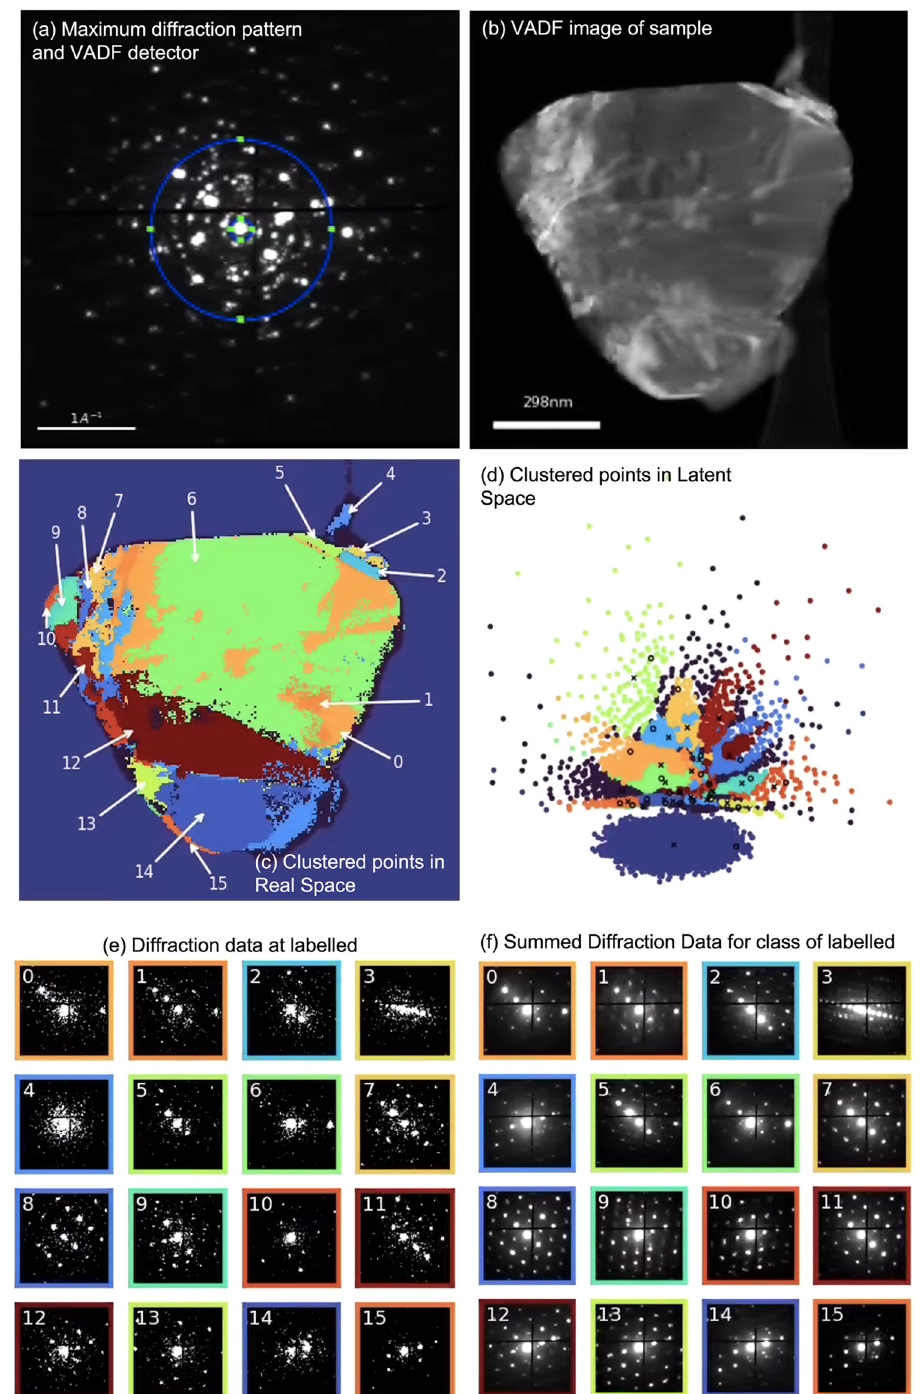
Fig. 6 Example domain mapping of a layered metal oxide dataset. a The maximum diffraction pattern of the entire dataset with a virtual annular detector. The scale bar represents a length of 1 Å − 1 . b The virtual annular dark fi eld (VADF) image for the layered metal oxide dataset. The scale bar represents a length of 298 nm. c The clustering on the real space pixel locations, a pixel location has been highlighted in each of the identi fi ed domains. d The encoded positions of the patterns clustered by colour. The open black circles show the initial centroids identi fi ed by NMF and re fi ned by SSI. The black crosses show the new centroids by averaging the locations of points within clusters. e The single diffraction pattern corresponds to the pixel highlighted in ( c ) and the pattern border colour corresponds to the colour of the class in the segmentation. f The mean diffraction pattern corresponds to the class of the pixel highlighted in ( c ) and the pattern border colour corresponds to the colour of the class in the